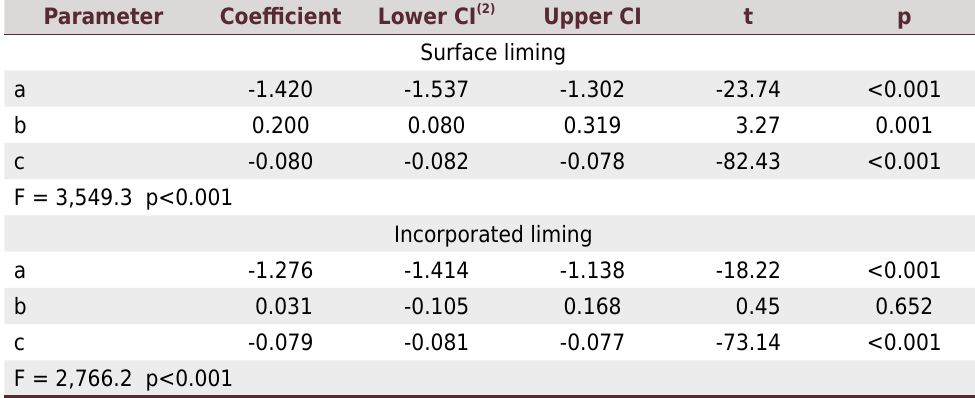
Table 3. Estimators of the equation of soil water content (θ) (1)